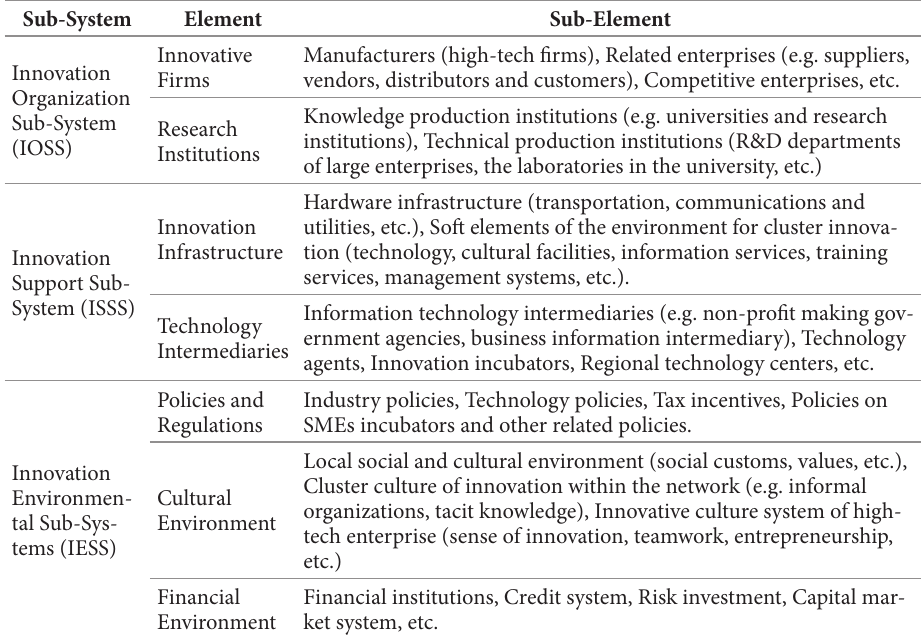
Table 1. Elements of Innovation System for Science Parks